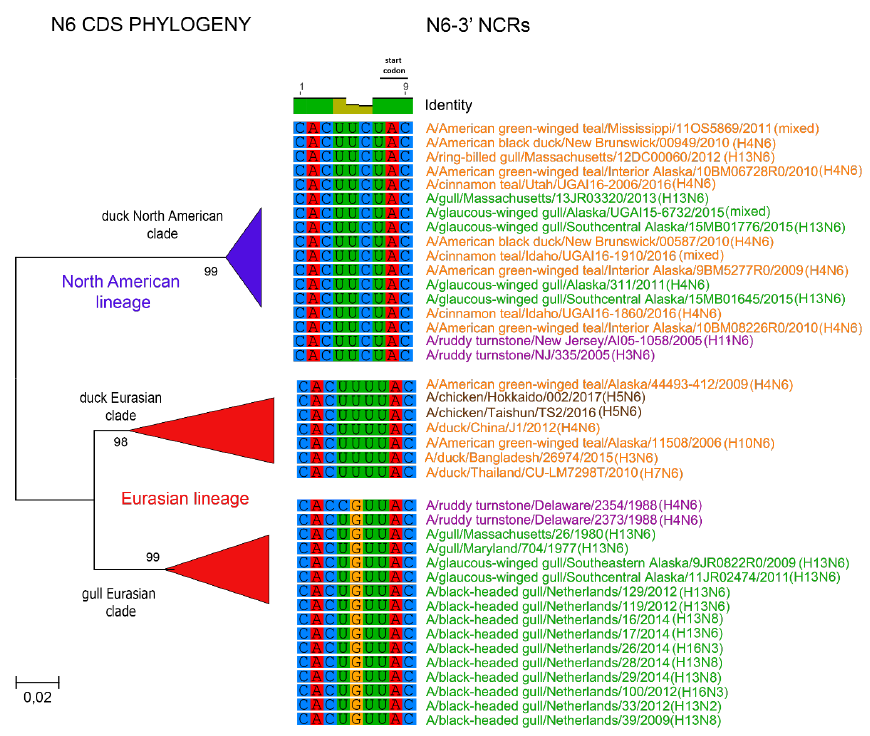
Figure 7. Relationships among N6 3 ′ NCR and CDS regions for viruses from different host species and geographic locations. Alignments of the 3 ′ NCRs, shown corresponding to the genomic RNAs, from the viruses used in the analyses are next to the CDS-based neighbor-joining tree for these viruses. To facilitate the distinction of viruses from different hosts, gull viruses are in green, duck viruses are in orange, shorebird viruses are in purple, and chicken viruses are in